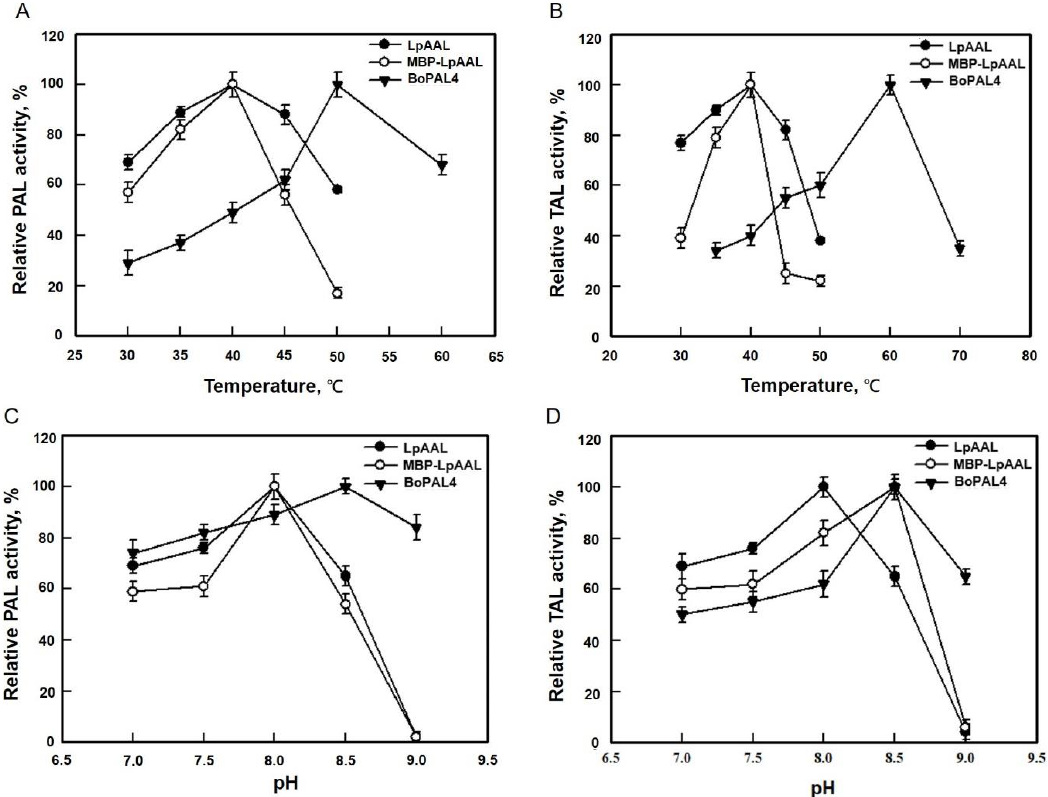
Figure 6. Optimum reaction temperature and pH of PAL and TAL activities of LpAAL, MBP-LpAAL and BoPAL4 enzymes. ( A ) PAL activities were measured under standard assay conditions in a range of temperatures from 30 to 60 °C. ( B ) TAL activities were measured under standard assay conditions in a range of temperatures from 30 to 60 °C. ( C ) PAL activities were measured under standard assay conditions in a range of pH from 7.0 to 9.0. ( D ) TAL activities were measured under standard assay conditions in a range of pH from 7.0 to 9.0. All experiments were performed in trip- licate and expressed as average ± standard deviation (S.D., error bars). The average of maximum activity was normalized as 100%.